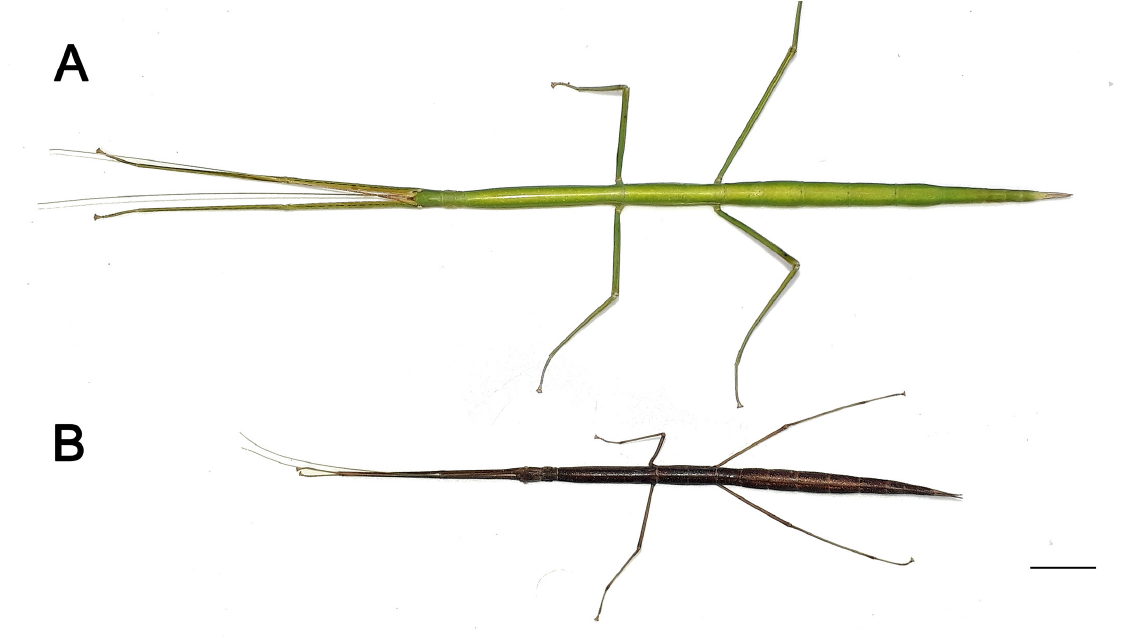
Fig. 46. Comparison of live adult females. A . Arumatia motenata Ghirotto gen. et sp. nov. B . Arumatia dubia gen. et comb. nov. Scale bar: 10